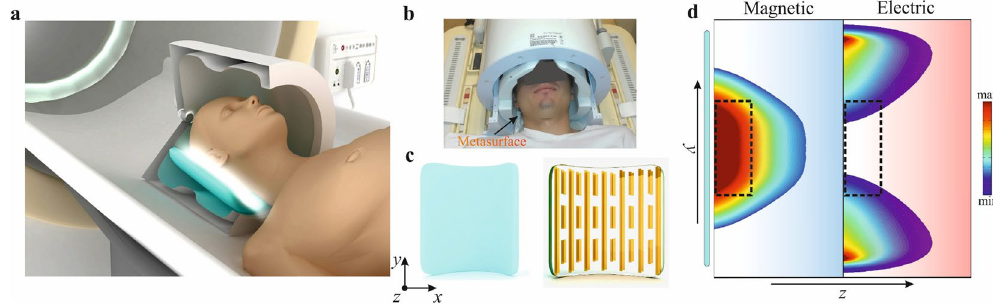
Figure 1. Structural geometry of the metamaterial and simulation of near field magnetic and electric field distributions. ( a ) Schematic of the MRI setup with a cut-out for better visualization of the setup. ( b ) A photograph of the in-vivo experiment including the transmit (outer) and multi-element receive coil array (inner). ( c ) Artist’s view of the hybrid metasurface, including high permittivity dielectric substrate (left) combined with its metallic structure (right). ( d ) Numerically calculated magnetic (left) and electric (right) field maps in vacuum near the metasurfaces (shown as a blue rectangle). The region of interest is depicted as a black dashed